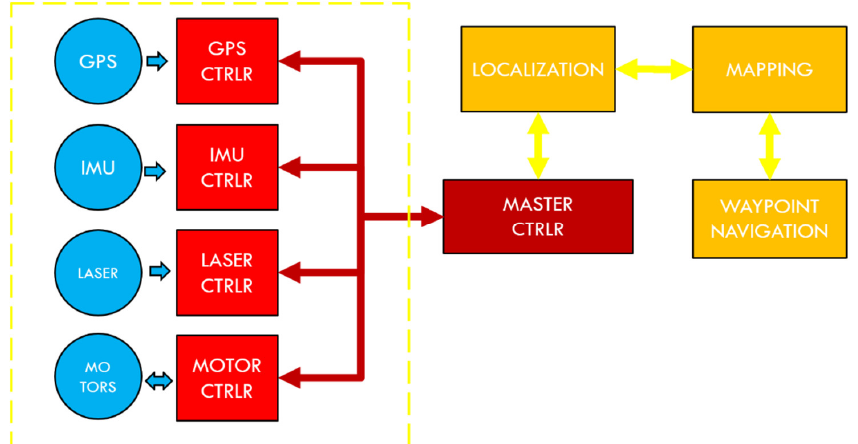
Figure 10. Hardware and software components for UGVs navigation.